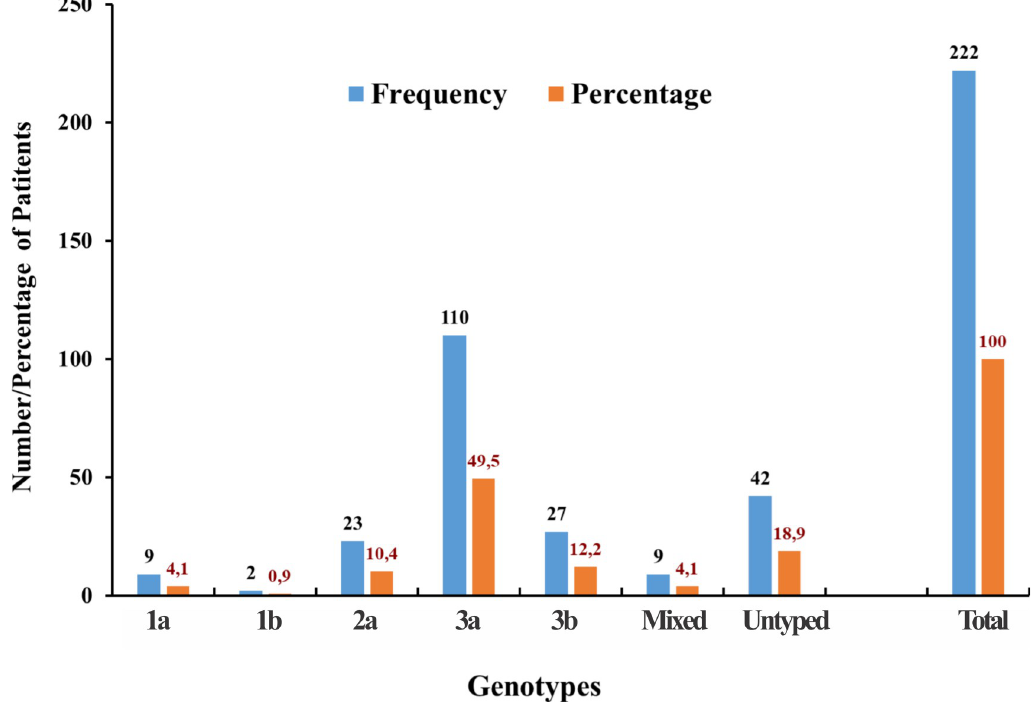
Fig 2. Distribution of HCV genotypes (1b, 2a, 3a, 3b, mixed and untyped) in the patients with chronic HCV hepatitis.